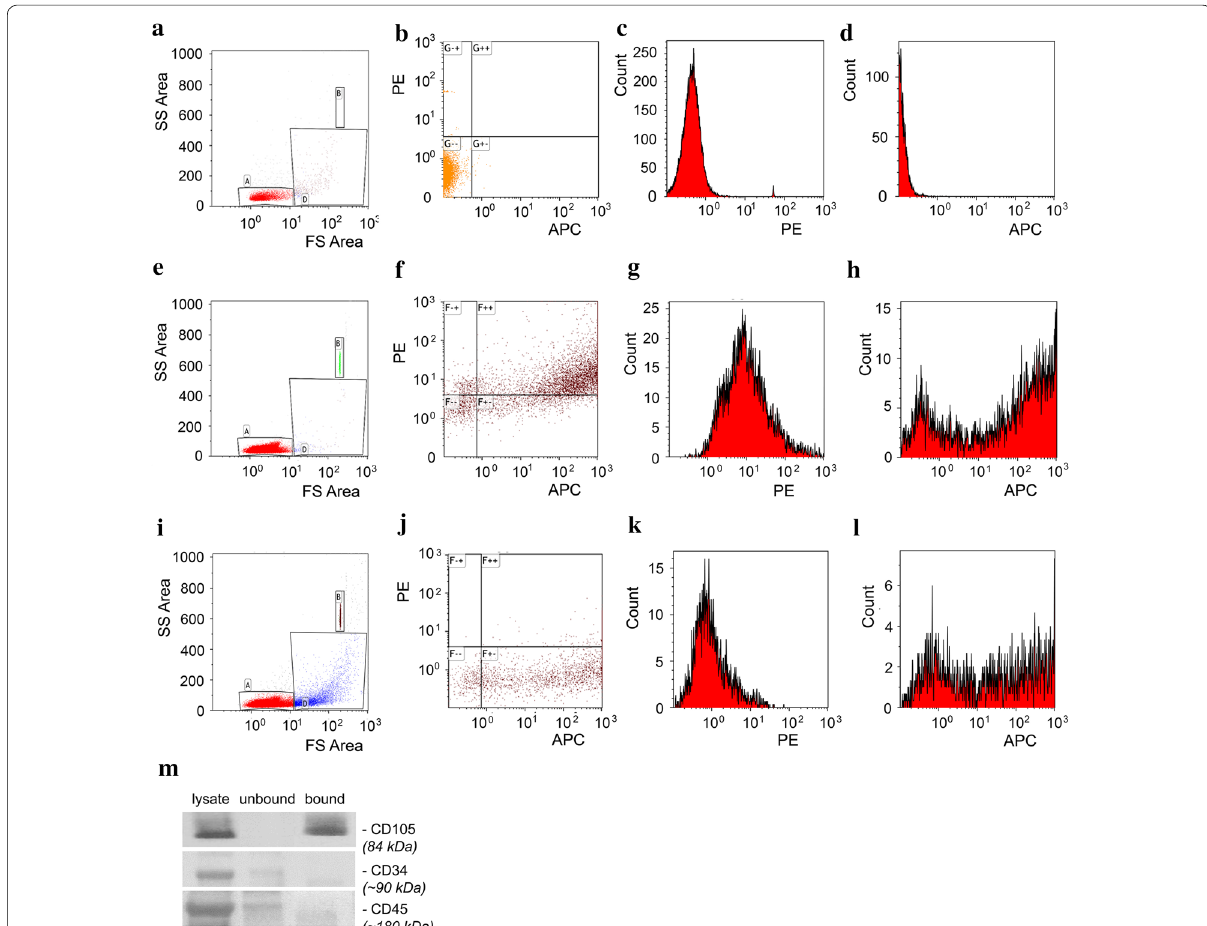
Fig. 3 EV ARDS Alk5 sub-population is derived from the MSCs. Unstained EVs were used as controls to determine fluorescence background as well as for gating purposes. a Representative forward and side scatter plot for unstained EVs. Background fluorescence in the PE and APC channels for the unstained samples shown as dot plot ( b ) and individual histograms ( c , d ). Similar, representative plot of EVs stained with Alk5-APC/CD105-PE Abs ( f ) to analyze the co-expression of these markers on the EV ARDS ( e , Gate D), together with the individual histograms for CD105-PE ( g ) and Alk5-APC ( h ). Representative plot of EVs stained with Alk5-APC/CD73-PE Abs ( j ) to analyze the co-expression of these markers on the EV ARDS ( i , Gate D), along with the histograms for CD73-PE ( k ) and Alk5-APC ( l ) are also shown. n 9 EV ARDS and 5 EV Ctrl isolates. m Representative immunoisolation of CD105 + = EV ARDS Alk5 via biotin-conjugated CD105 Ab and streptavidin magnetic beads incubation. Lysates of EV ARDS , bound and unbound EV ARDS fractions were analyzed by SDS PAGE and WB. No immunoreactivity to CD45 and CD34 is detected. n 6 EVs isolates/experimental condition, in three = independent